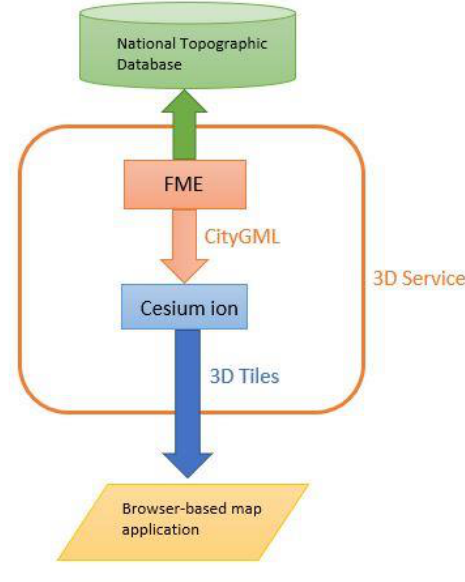
Figure 4. 3D Service